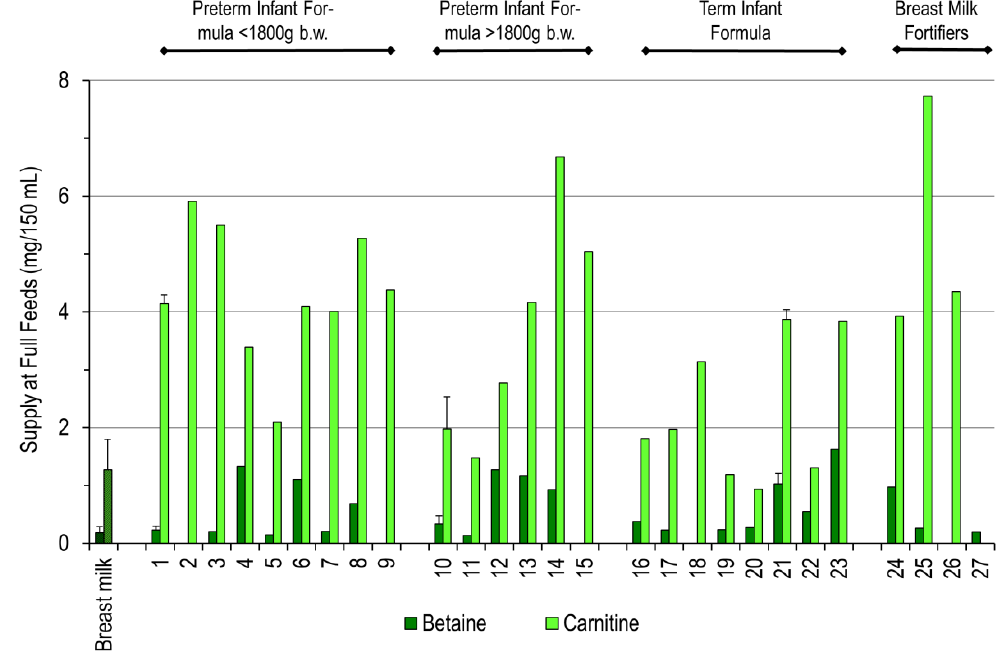
Figure 4. Daily Intake of Choline Derivatives containing a Trimethylated Nitrogen Group. Betaine is a metabolite derived from choline, whereas carnitine requires choline/betaine-derived activated methyl groups for synthesis. For details, see the legend to Figure 2. Individual product numbering is